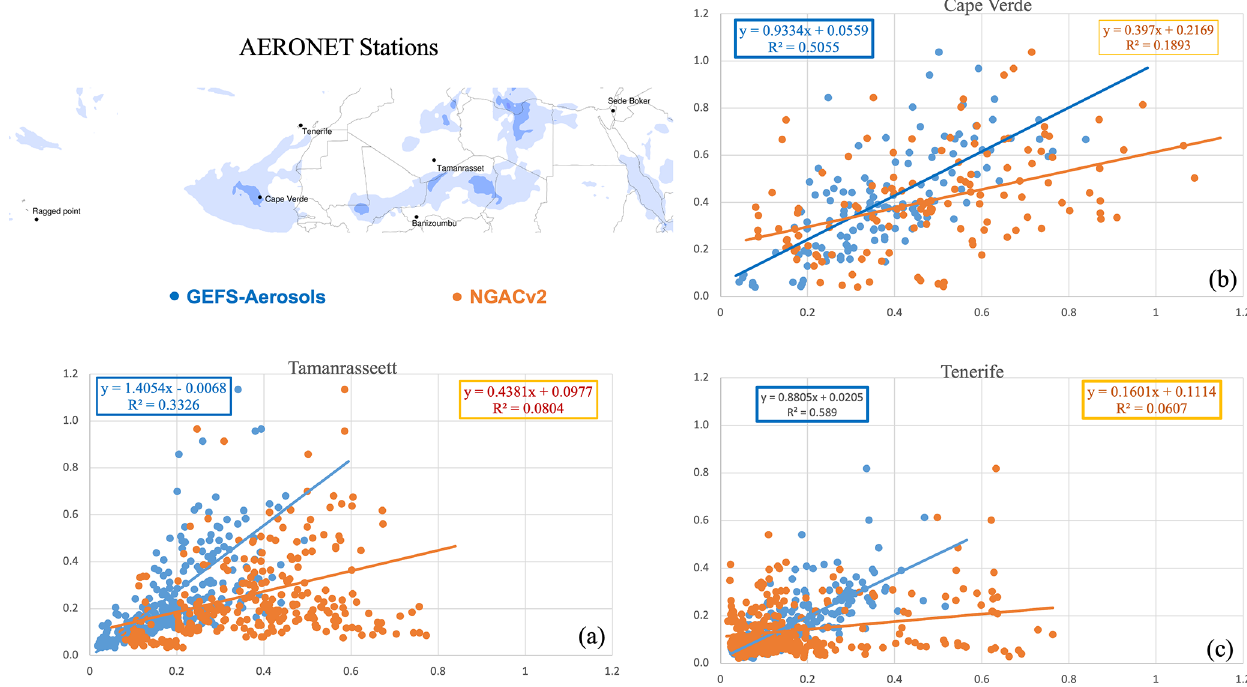
Figure 12. Daily AERONET total AOD vs. modeled total AOD from GEFS-Aerosols (blue) and NGACv2 (orange) at the AERONET sites of (a) Tamanrassett, (b) Cape Verde, and (c) Tenerife with linear regression